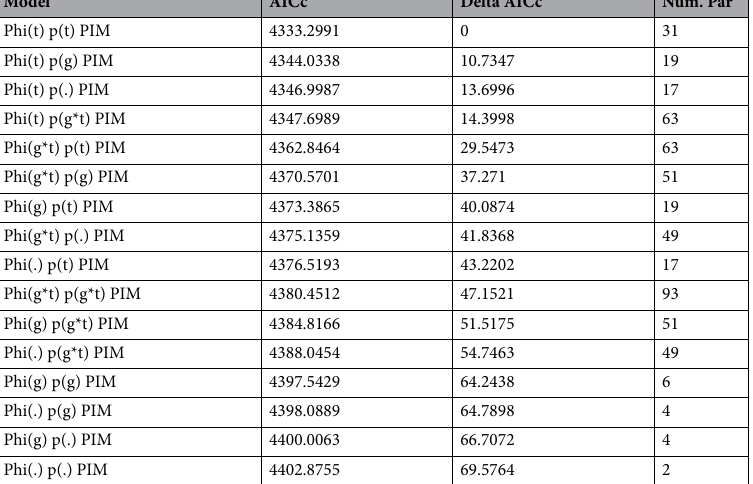
Table 2. Ranking of Cormack-Jolly-Seber models estimating survival (Phi) and recapture rate (p) of sea snakes in Baie des Citrons south and Anse Vata. Models differ in whether or not survival and recapture rates are constant (.), vary over time (t), vary among colour morph groups (g) or vary interactively with time and group (g*t). The top-ranked model (one in which both survival and recapture rates varied over time) fit the data better than the top model in which survival varied among colour morphs (Phi(g*t) p(t). AICc = corrected Akaike Information